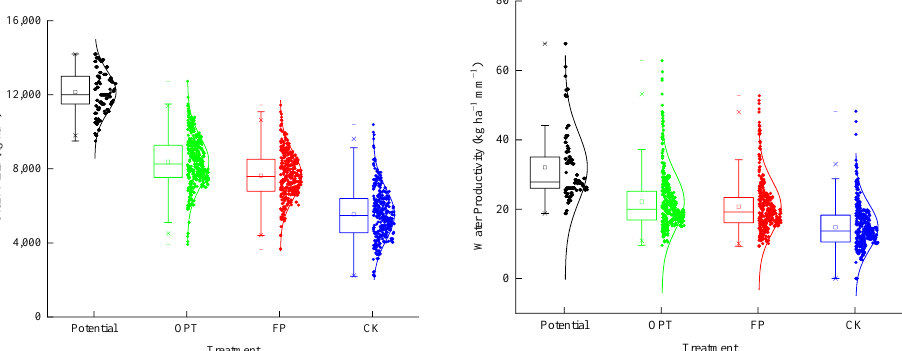
(achieved 8767 kg ha −1 yield and 28.1 kg ha −1 mm −1 WP) and LYLW (achieved 6580 kg ha −1 yield and 15.6 kg ha −1 mm −1 WP) groups, respectively (Figure 2). Compared with the HYHW group, the LYLW group exhibited a decrease in the yield by 24.9% and WP de- creased by 44.4%. Overall, 21.9% and 12.2% of the total farmers were classified into the HYLW (average yield of 8558 kg ha −1 and WP of 17.9 kg ha −1 mm −1 ) and LYHW (average yield of 6926 kg ha −1 and WP of 26.4 kg ha −1 mm −1 ) groups, respectively. Therefore, con- siderable yield and WP gaps were observed among the farmers.